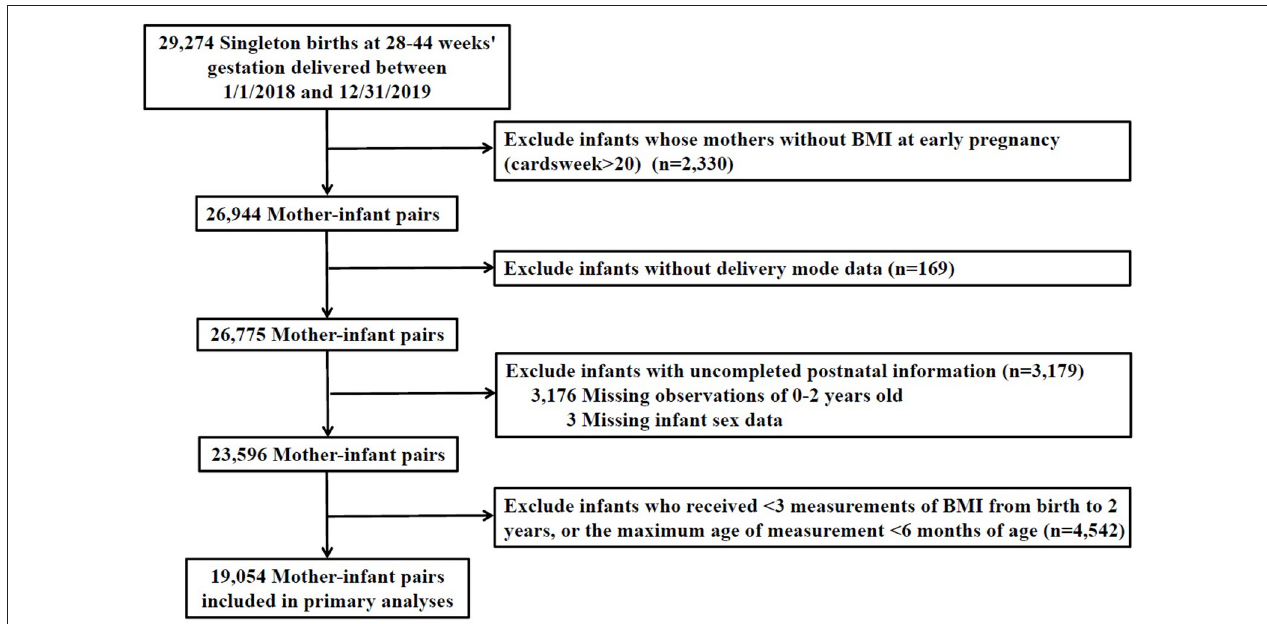
FIGURE 1 | Flow chart for selection process of the